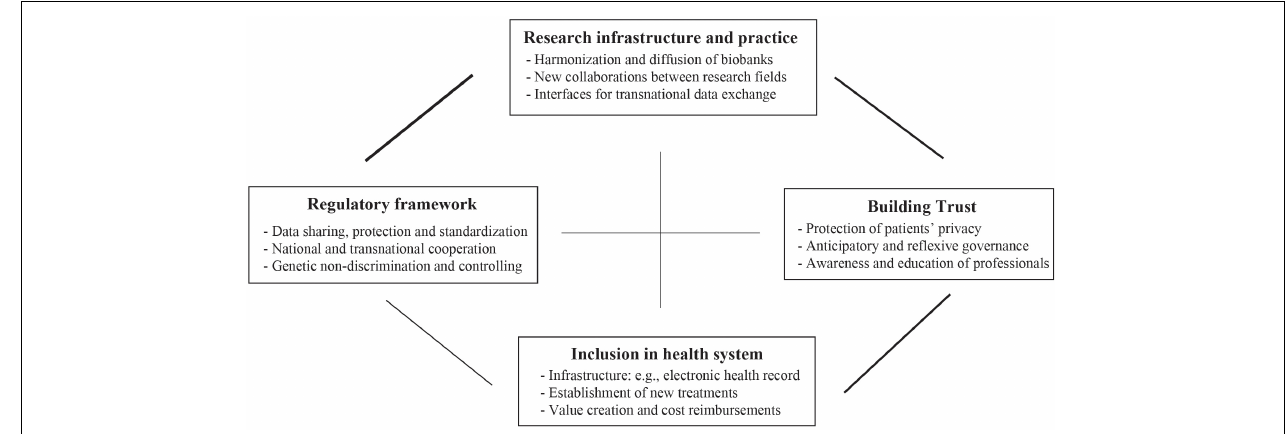
FIGURE 3 | Four governance